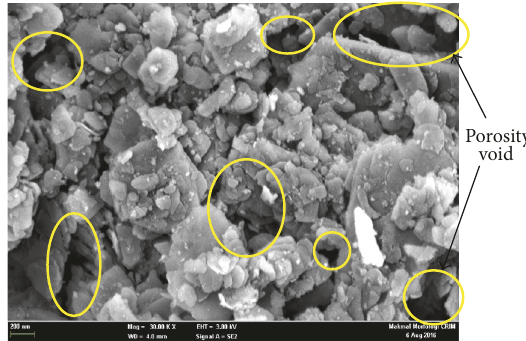
Figure 8: FESEM micrograph of original soil: Mag = 30.00